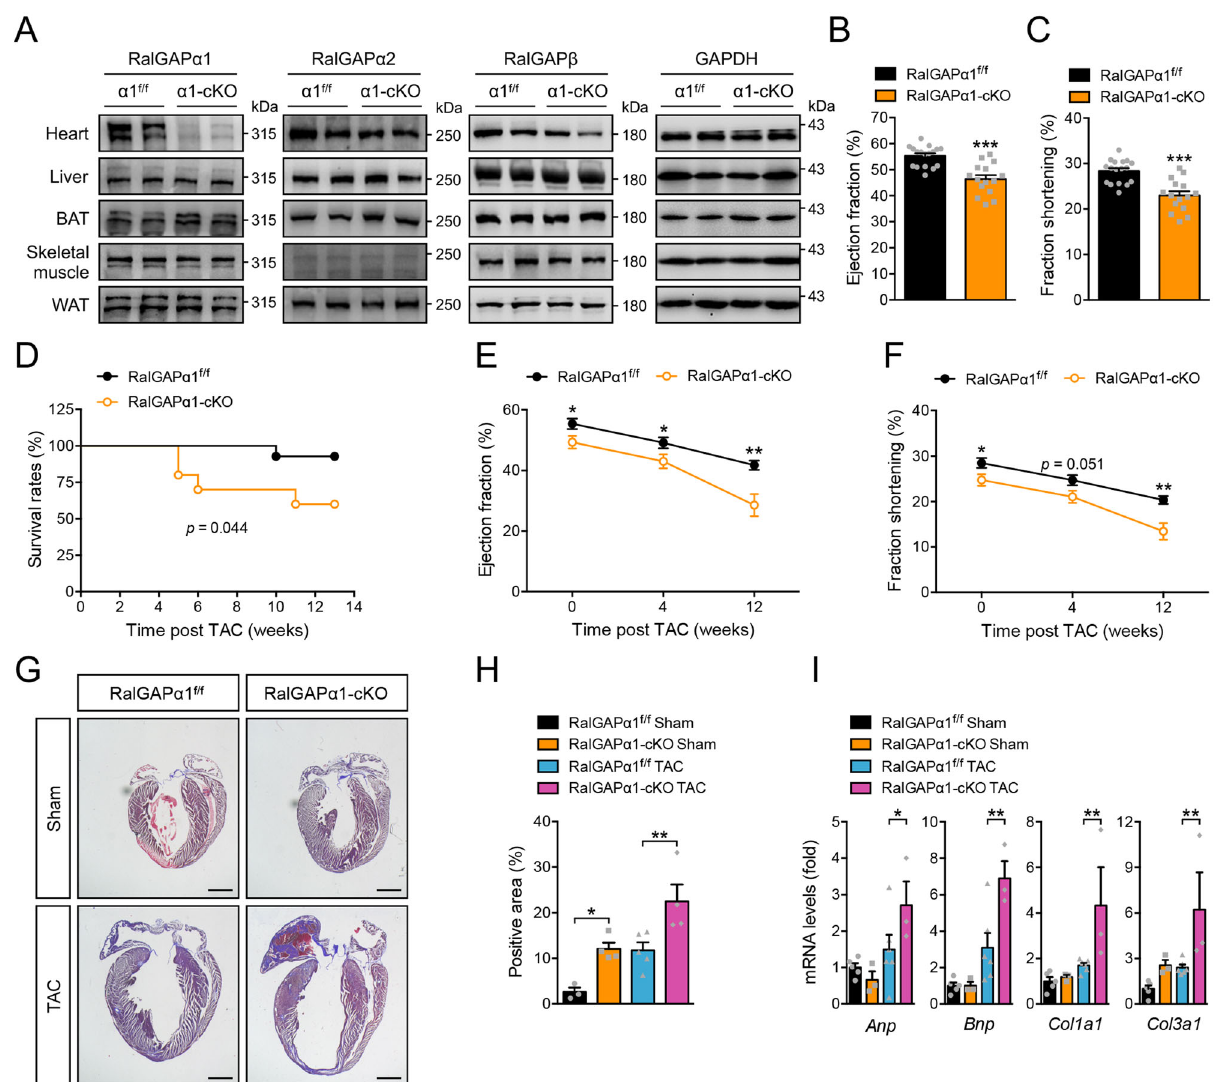
Fig. 2 | Cardiac function and remodeling in the RalGAP α 1-cKO heart under basal and TAC conditions. A Protein expression of RalGAP α 1, RalGAP α 2, and RalGAP β in various tissues of male RalGAP α 1-cKO mice (3-month-old). GAPDH was used asaloading control. B-C.Ejectionfraction B and fractionalshortening C were measuredviaechocardiographyinthemaleRalGAP α 1-cKOandRalGAP α 1 f/f mice(3- month-old). n =15(RalGAP α 1-cKO) and 17(RalGAP α 1 f/f ). p =1.99e-5(EF)and 2.73e-5 (FS). D Survival rates of the male RalGAP α 1-cKO and RalGAP α 1 f/f mice after TAC. n =10 (RalGAP α 1-cKO) and 14 (RalGAP α 1 f/f ). p =0.044. E , F Ejection fraction E